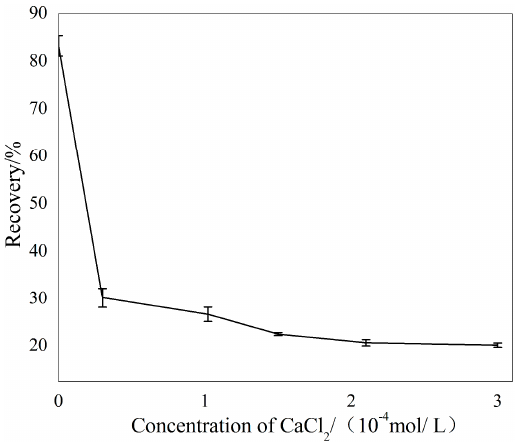
Figure 4. The flotation recovery of sillimanite as a function of Ca 2+ ions concentration with 4.50 × 10 − 4 M, DAC at pH = 7.0.